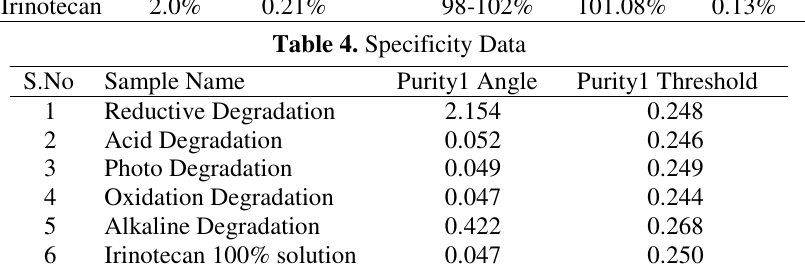
Table 3 . Precision